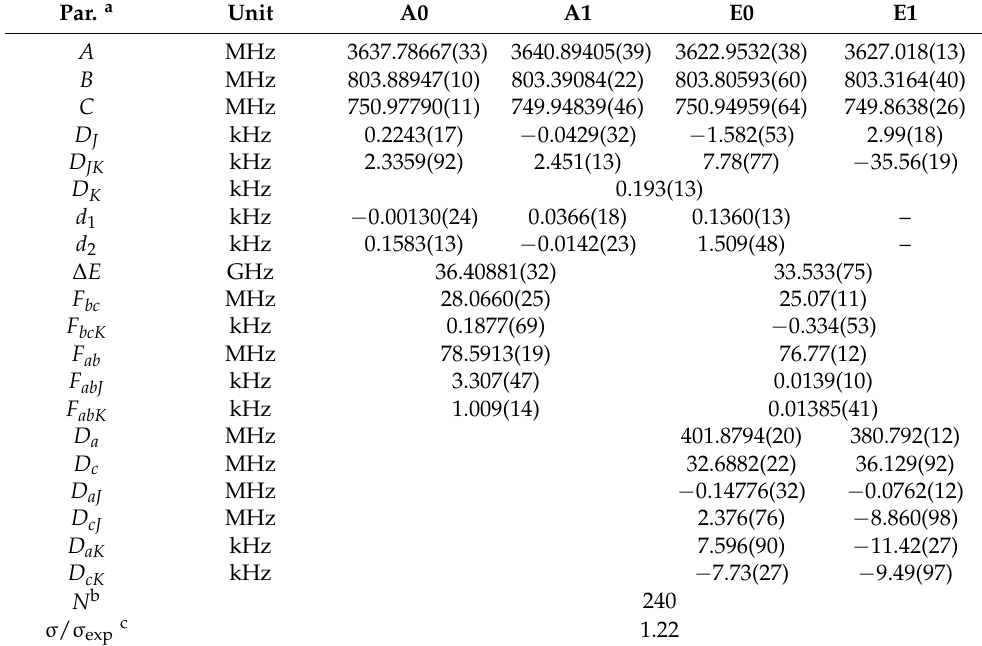
Table 1. Molecular parameters obtained from a simultaneous fitting of the A0, A1, E0 and E1 sub- state lines of phenyl acetate using the program spfit .